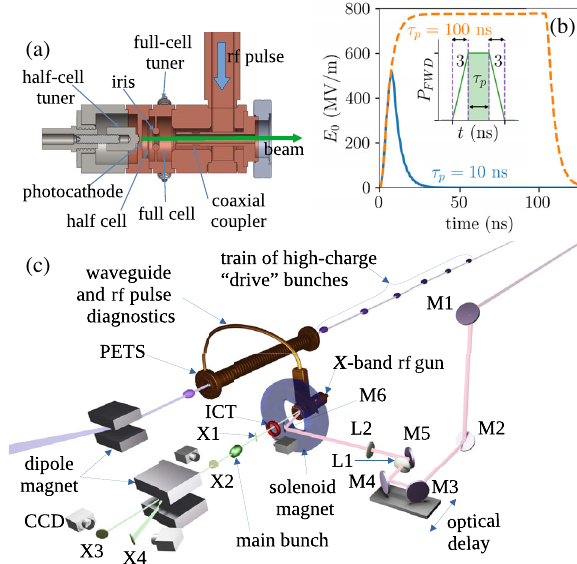
FIG. 1. Schematic of the XRF gun (a) and simulated peak field on photocathode (b) for a short ( τ p ¼ 3 -ns, solid trace) and long ( τ p ¼ 100 -ns, dash trace) flattop 300-MW peak power rf pulse (the inset details the forward power P rf-pulse profile with FWD 3-ns rising and falling edges). Overview of the experimental setup (c): the upper (magenta) path corresponds to the relevant section of the AWA main accelerator and the lower (green) path is the XRF gun beamline. The pink path shows the UV laser path. The labels X i , M i , and L i , respectively, refer to Ce ∶ YAG scintillating screens with CCD cameras, optical mirrors, and